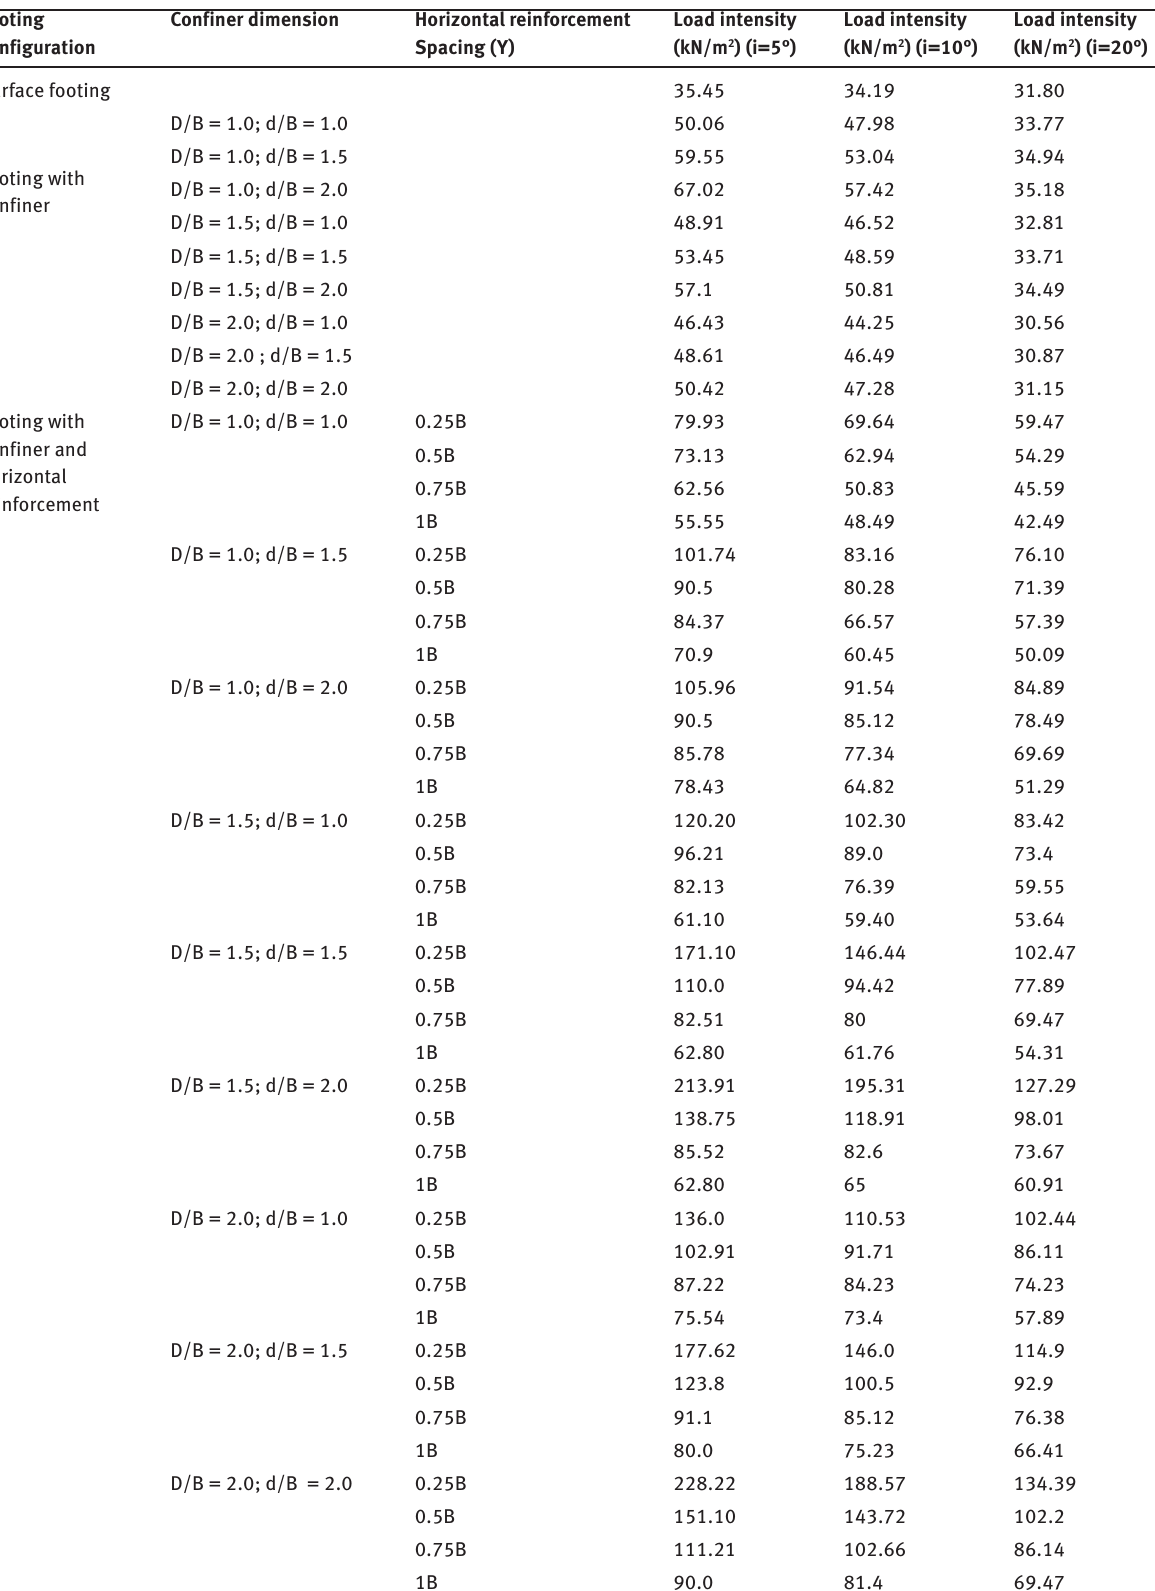
Table 3: Ultimate load intensity for different footing configurations under centric inclined loading. Footing